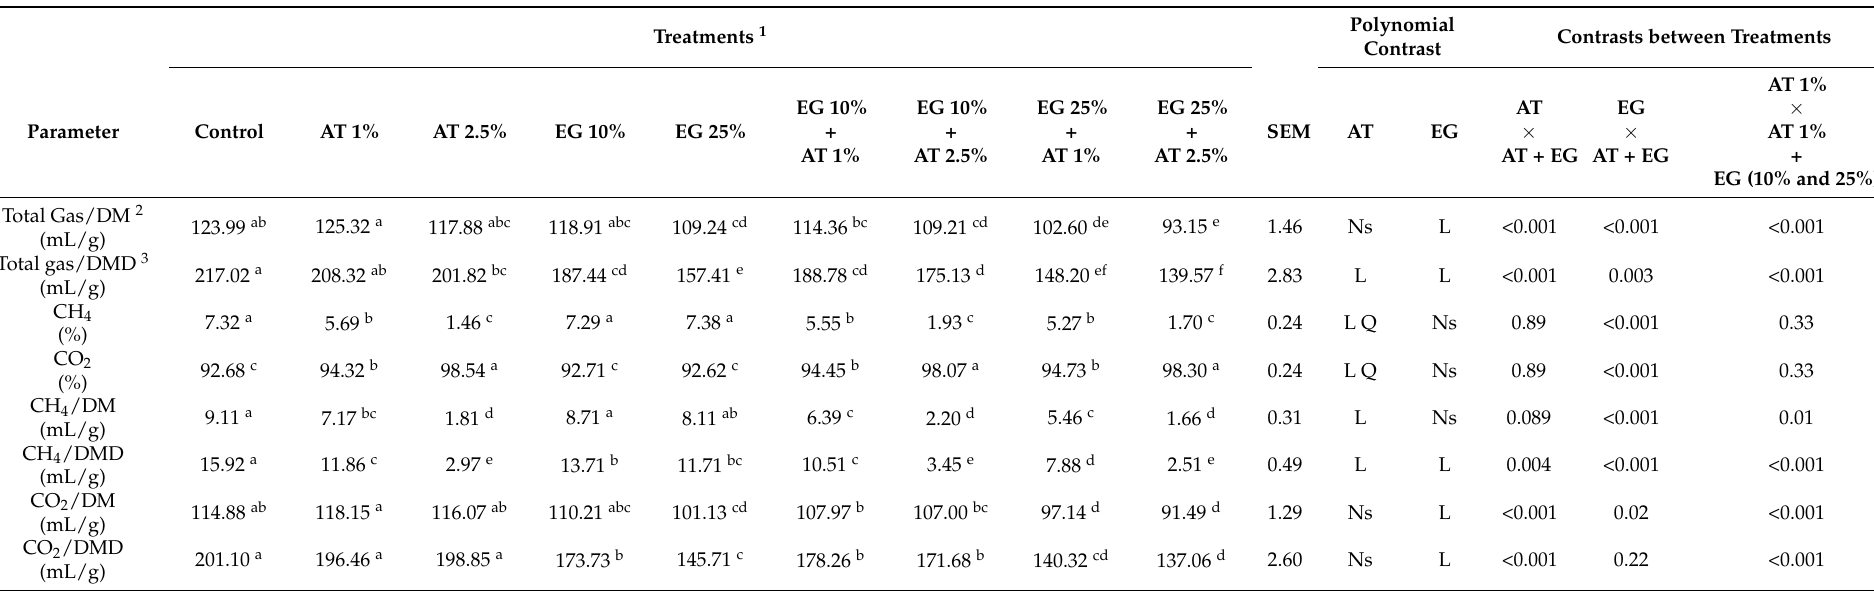
Table 5. Effect of Euglena , Asparagopsis , and their combination on gas production profile from 24 h in vitro incubation (n =